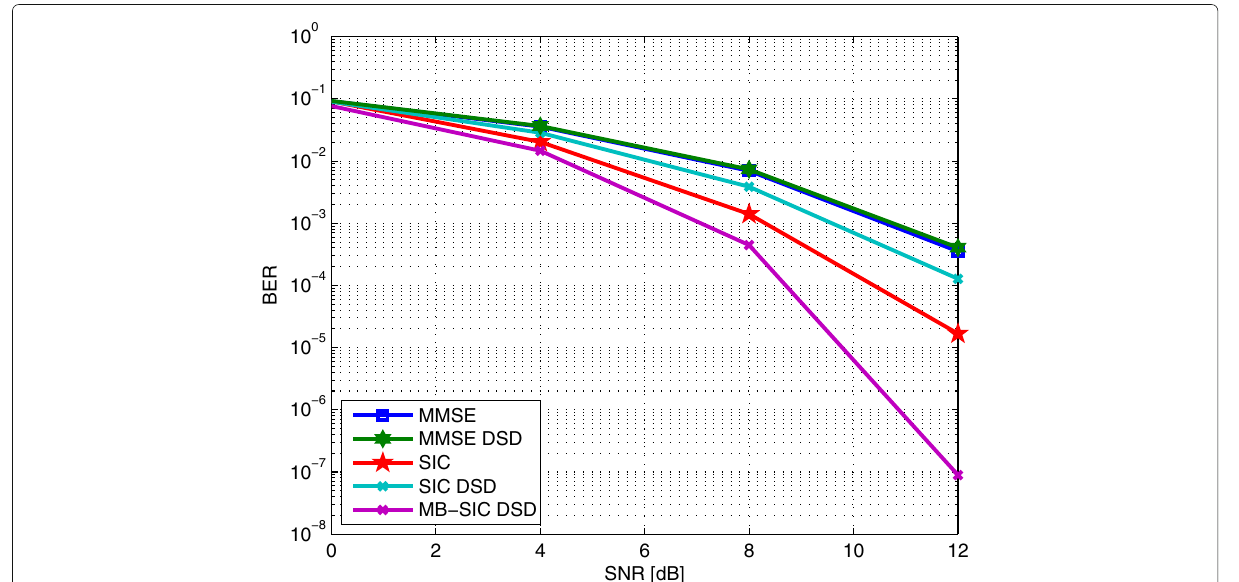
= 8 transmit antennas per user, N = 8 classes of users, and N k , n